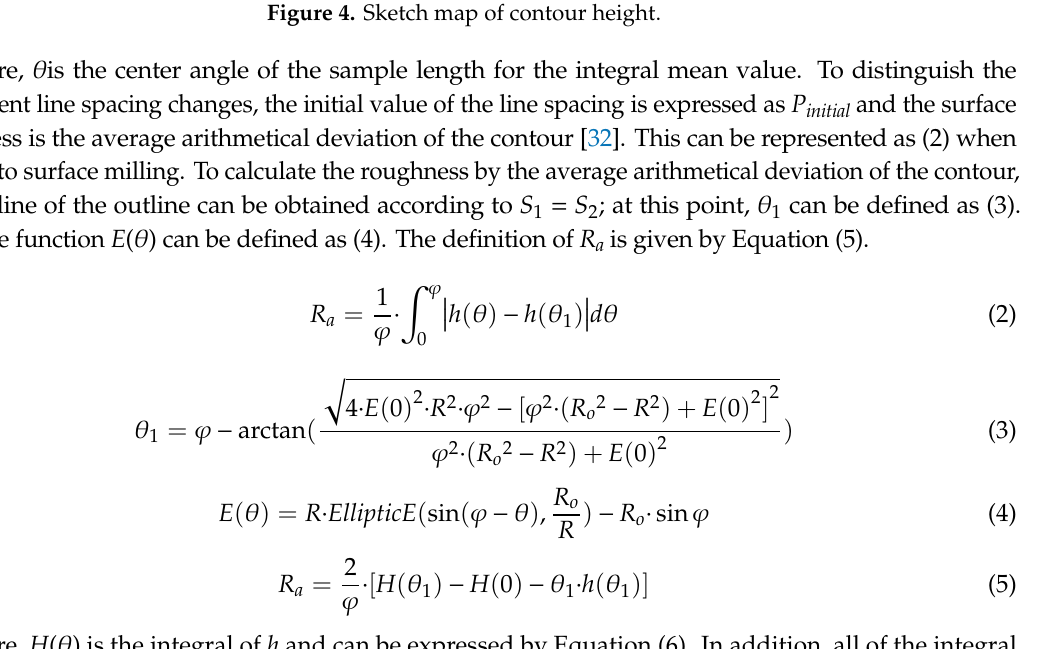
Figure 4. Sketch map of contour height.